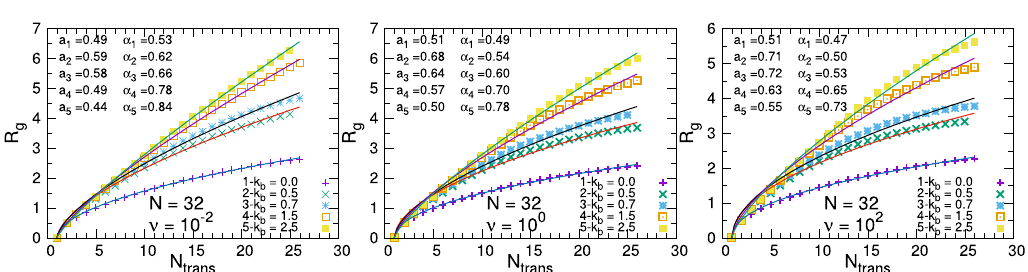
Figure 10. Polymer gyration radius as a function of the number of monomers reaching the trans region, N trans , on the translocation of N = 32 polymers. Each point results of an averaging over the N exp realisations. The curves are fitted to f ( N trans ) = a ( N trans − 1) α